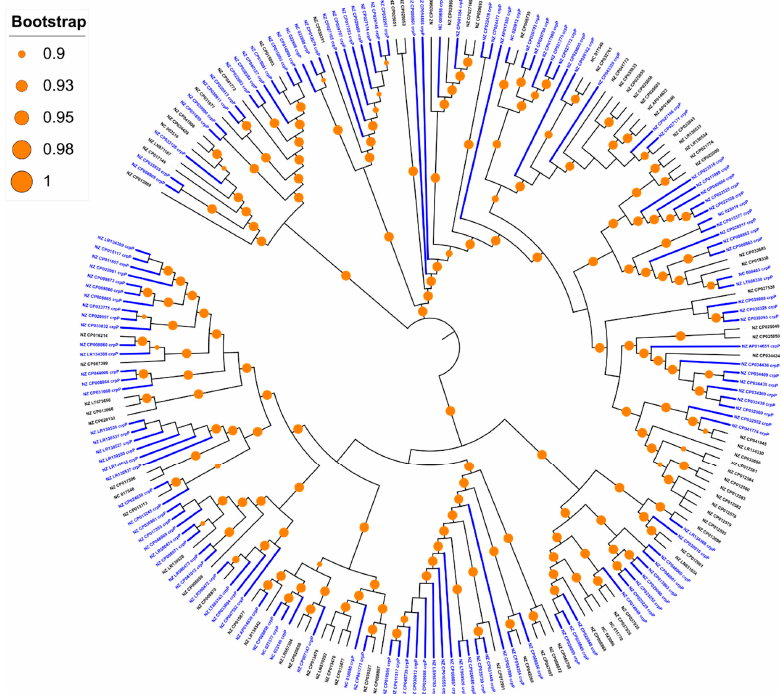
Figure 1. Approximately-maximum-likelihood phylogenetic tree base on the core genome alignment of 215 complete P. aeruginosa genomes. Branches and labels from crpP -positive hits are colored blue and the branches have twice the standard width. Branch lengths are ignored. Bootstrap values between 0.9 and 1 are represented by orange circles.